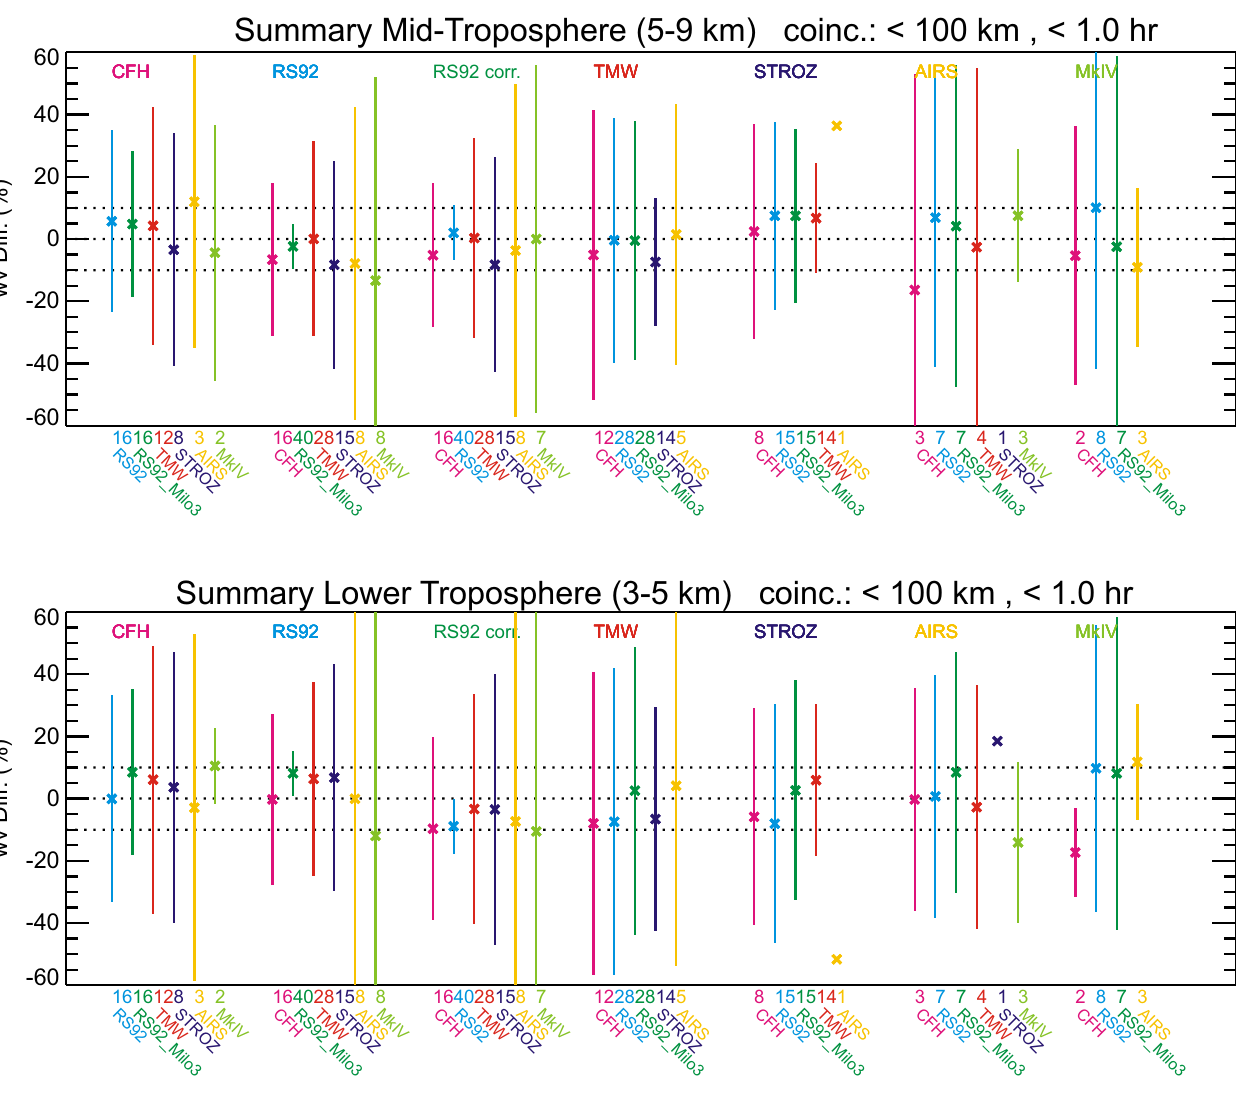
Fig. 16. Cross-comparison of the water vapor datasets available in the lower troposphere (bottom) and mid-troposphere (top) during MOHAVE-2009. The symbols indicate the differences (in %) between the measurement listed in the upper part of each plot and those listed in the lower part (where the number of coincidences is listed). The vertical bars indicate the spread the differences (r.m.s.). Use the colors to better identify the